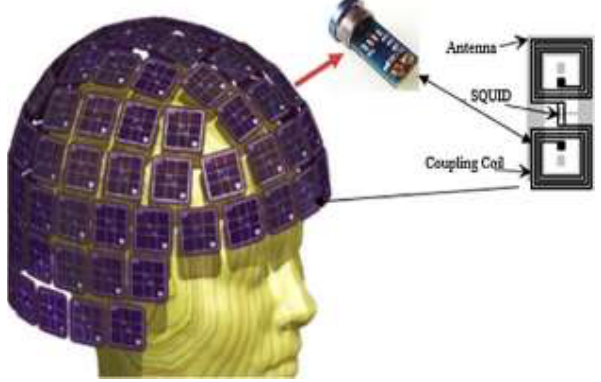
Figure 9: SQUID detector and the graphic connection of the coil in a Superconducting state.